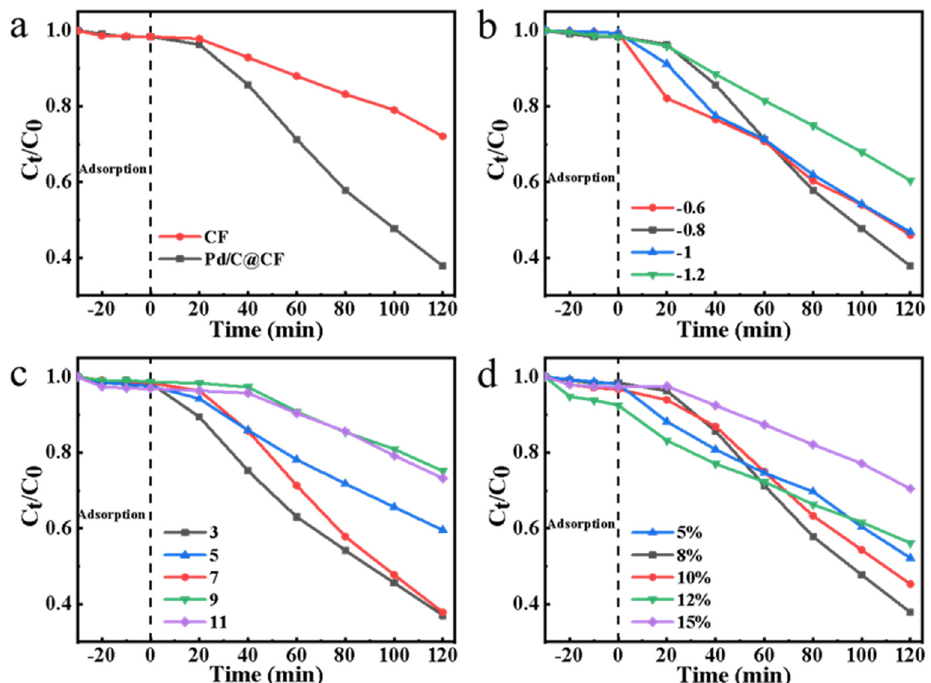
Figure 4. The degradation efficiency of norfloxacin ( a ) with or without Pd/C catalyst on carbon felt (Na 2 S 2 O 8 , 3 mM; norfloxacin, 10 mg/L; pH, 7.0; applied potential, − 0.8 V vs. Ag/AgCl; Pd loading, 8 wt%); ( b ) at different applied voltages (Na 2 S 2 O 8 , 3 mM; norfloxacin, 10 mg/L; pH, 7.0; Pd loading, 8 wt%); ( c ) at different initial pH (Na 2 S 2 O 8 , 3 mM; norfloxacin, 10 mg/L; applied potential, − 0.8 V vs. Ag/AgCl; Pd loading, 8 wt%); and ( d ) at different Pd loading; (Na 2 S 2 O 8 , 3 mM; norfloxacin, 10 mg/L; pH, 7.0; applied potential, − 0.8 V vs. Ag/AgCl).